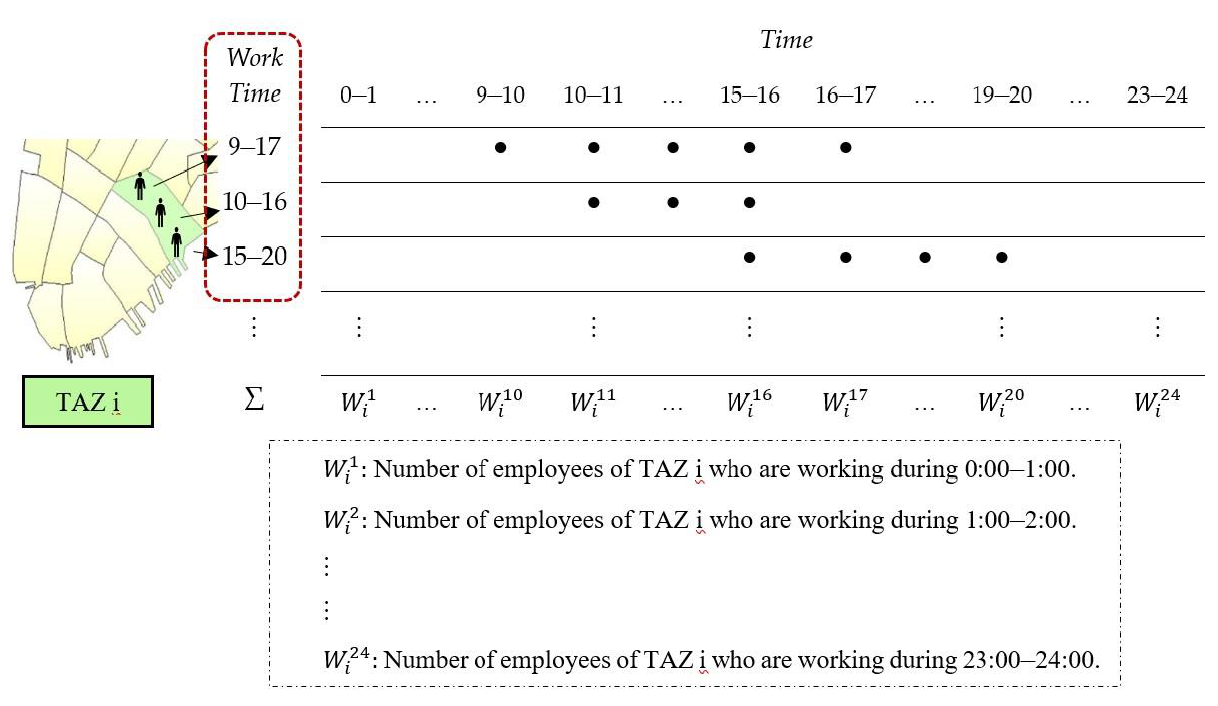
Figure 3. Splitting the work duration of employees into 1-h intervals.